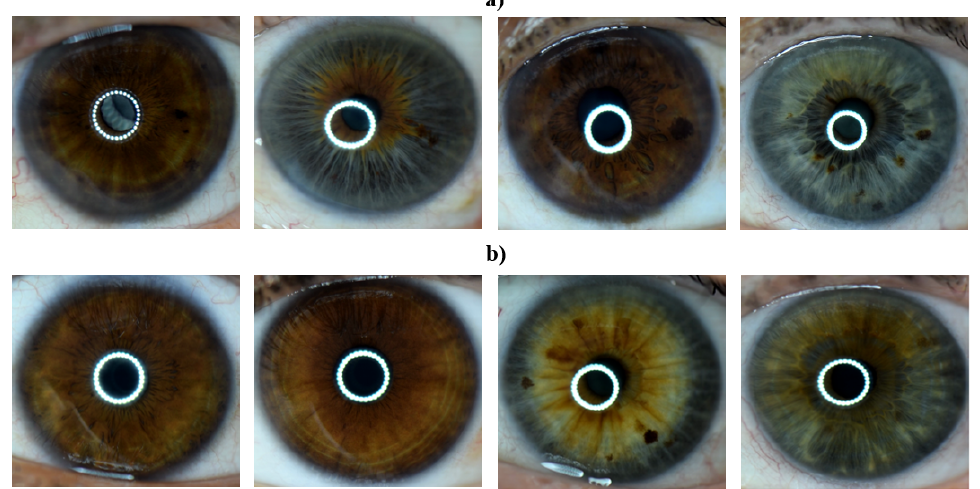
Figure 3. Iris images of the ( a ) CAD and ( b ) control group in the data set.